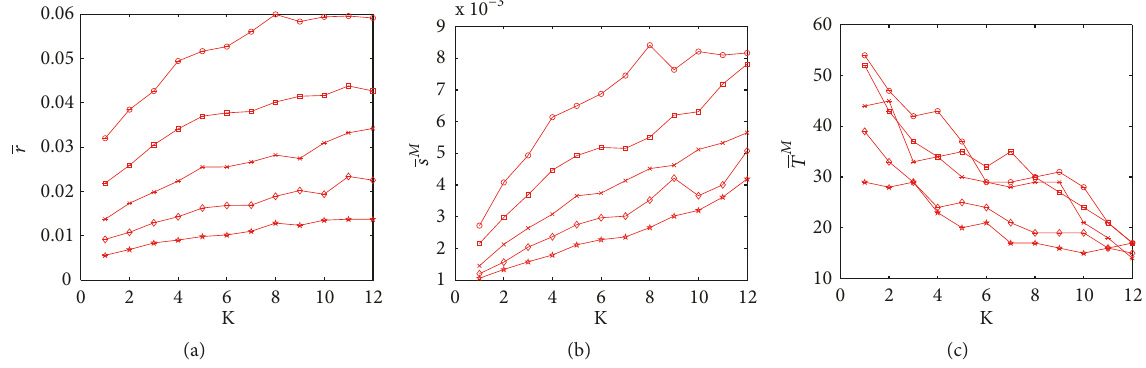
Figure 2: Three quantities of rumor propagation in Email-URV: (a) the average propagation size, (b) the average peak prevalence, and (c) the arrival time of the average peak prevalence when the spreading rate 𝛼 = 0.1(𝑠𝑡𝑎𝑟𝑠) , 𝛼 = 0.125(𝑑𝑖𝑎𝑚𝑜𝑛𝑑𝑠) , 𝛼 = 0.15(𝑓𝑜𝑟𝑘𝑠) , 𝛼 = 0.175(𝑠𝑞𝑢𝑎𝑟𝑒𝑠) , and 𝛼 = 0.2(𝑐𝑖𝑟𝑐𝑙𝑒𝑠) , respectively, and the decay rate 𝛽 = 1 . The performance of nodes in the higher layer is better.